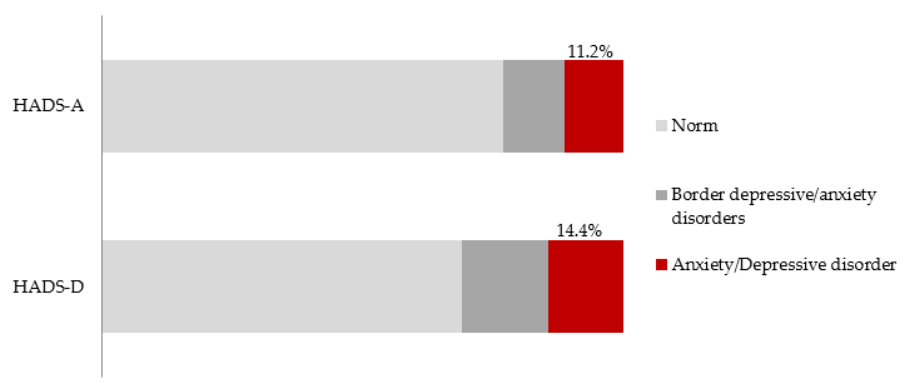
Figure 1. Results of the HADS-D and HADS-A subscales in the studied population. The examined risk factors were divided into groups. The first group included sociodemographic variables such as sex, age, marital status and place of residence. Detailed results obtained in the scale study are presented below (Table 2). To present the results, the study group was divided into subgroups depending on the result on the HADS scale. On the depression subscale (HADS-D), the sum of the points obtained by respondents from 0 to 7 points corresponds to the norm (HADS-D1), from 8 to 10 is the limit value of depression (HADS-D2) and a sum greater than or equal to 11 points represents an episode of depression (HADS-D3). On the anxiety subscales (HADS-A), the sum of points obtained during the study from 0 to 7 testifies to the norm (HADS-A1), a sum from 8 to 10 points is the limit value of an anxiety disorder (HADS-A2) and a sum greater than or equal to 11 points represents an anxiety disorder (HADS-A3). Table 2. Risk modifying factors and scores on the HADS-D and HADS-A subscales.